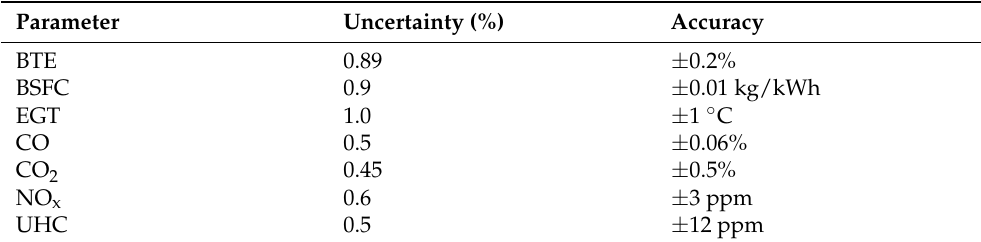
Table 3. Uncertainty and accuracy of